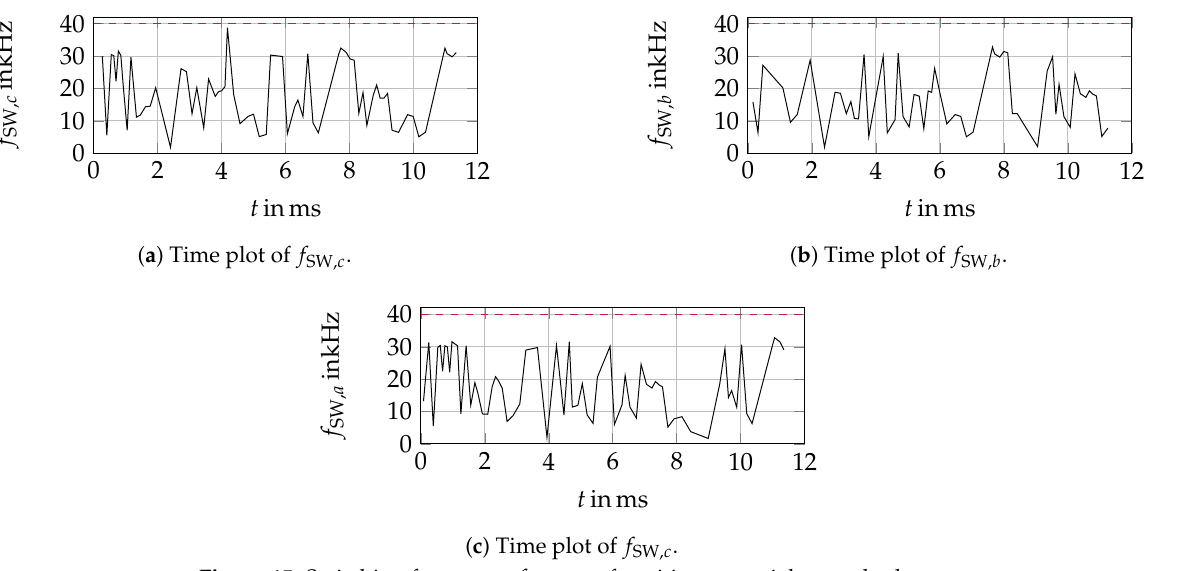
( c ) Time plot of f SW, c . Figure 15. Switching frequency f SW, c , b , a of positive potential on each